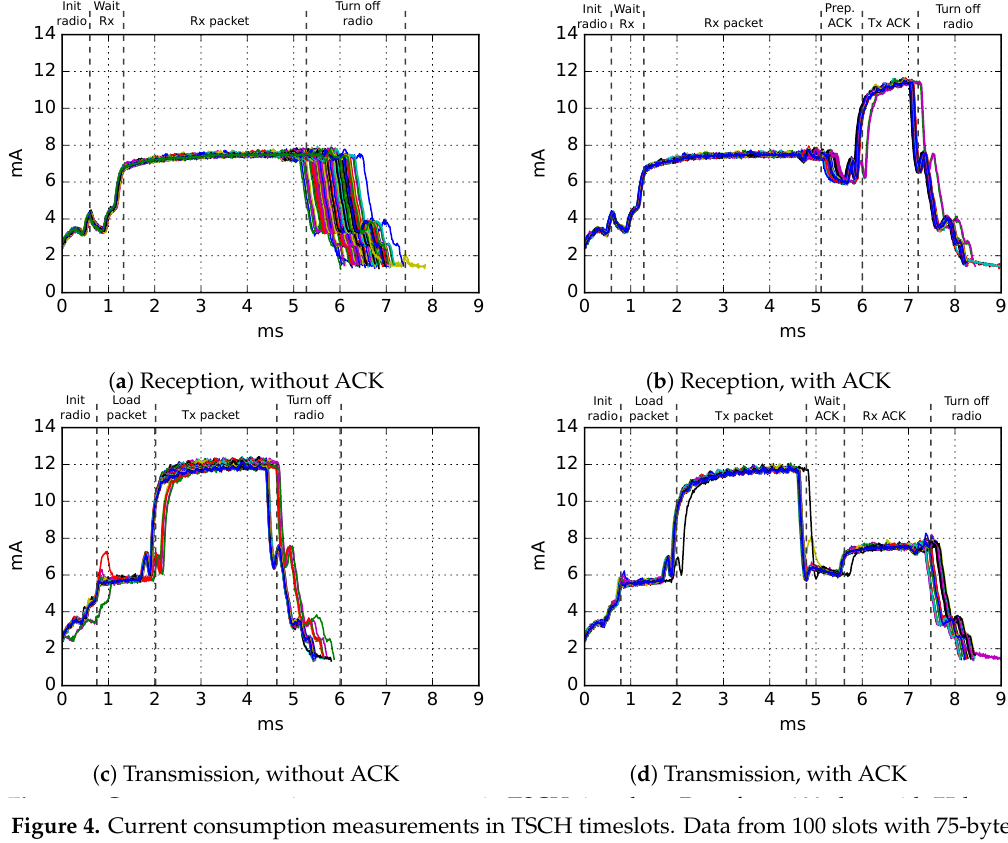
Figure 4. Current consumption measurements in TSCH timeslots. Data from 100 slots with 75-byte packets. The different colors denote measurements in different slots.